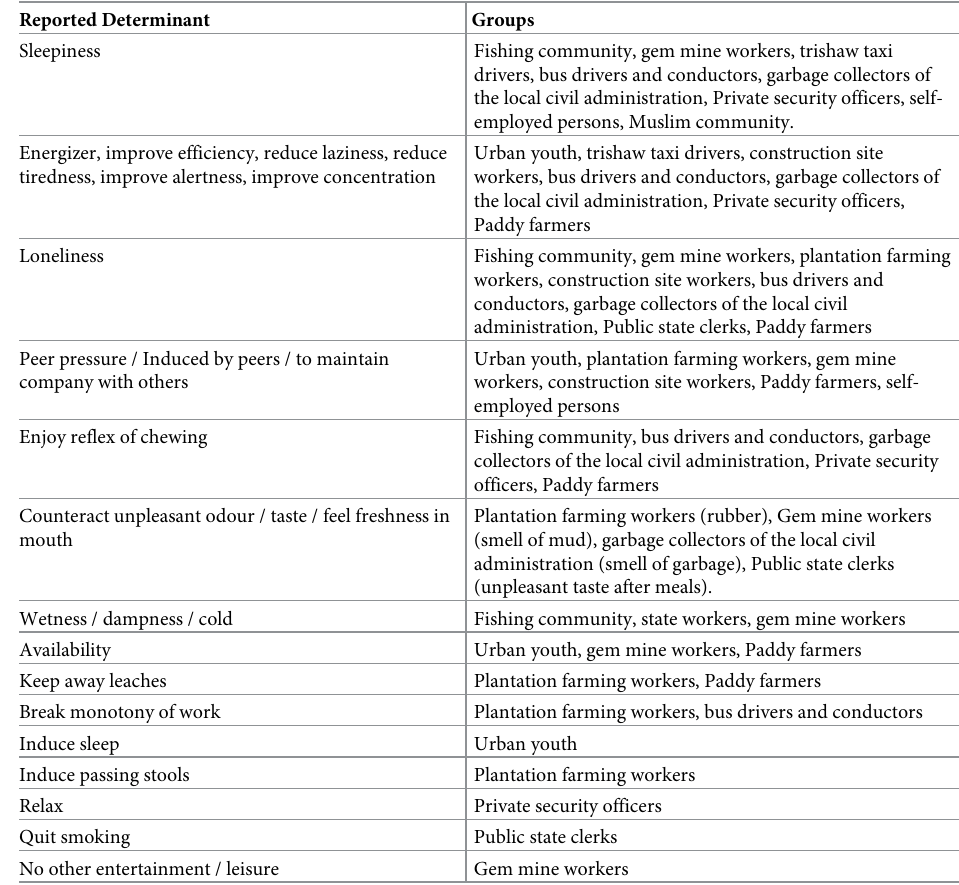
Table 2. Proximal reported determinants of